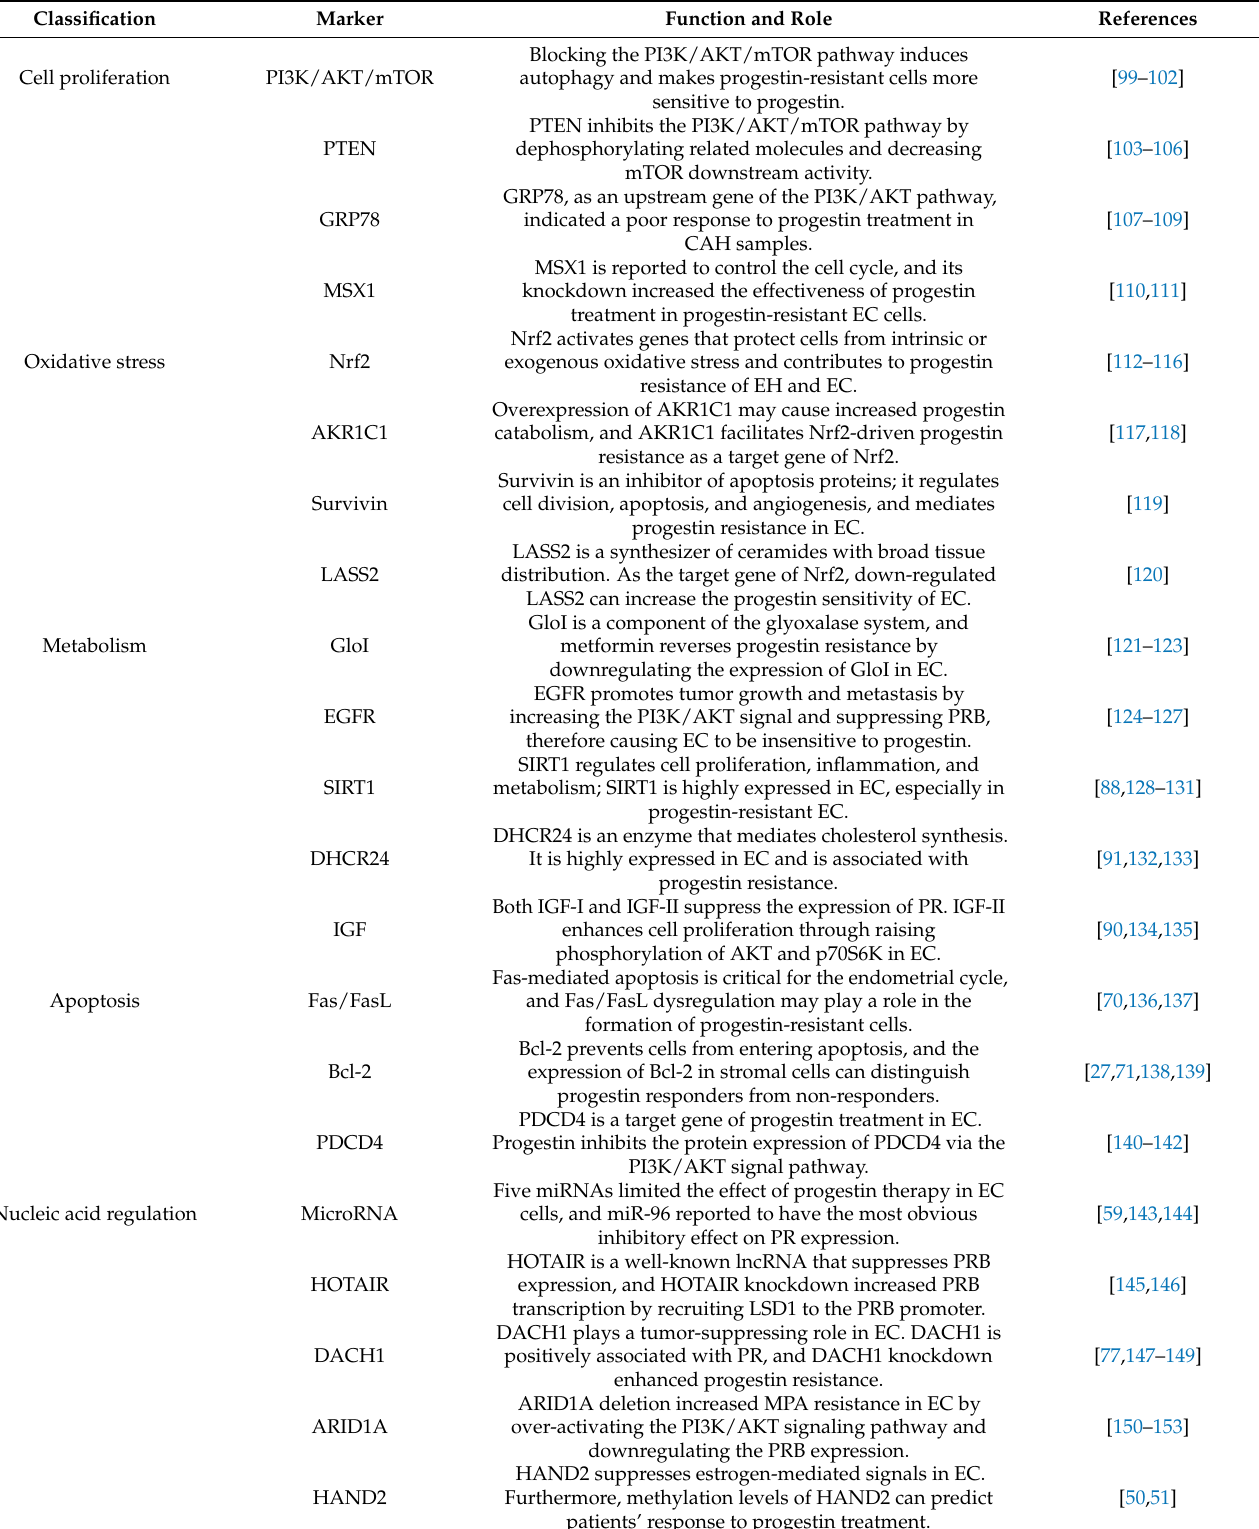
Table 1. The markers of progestin